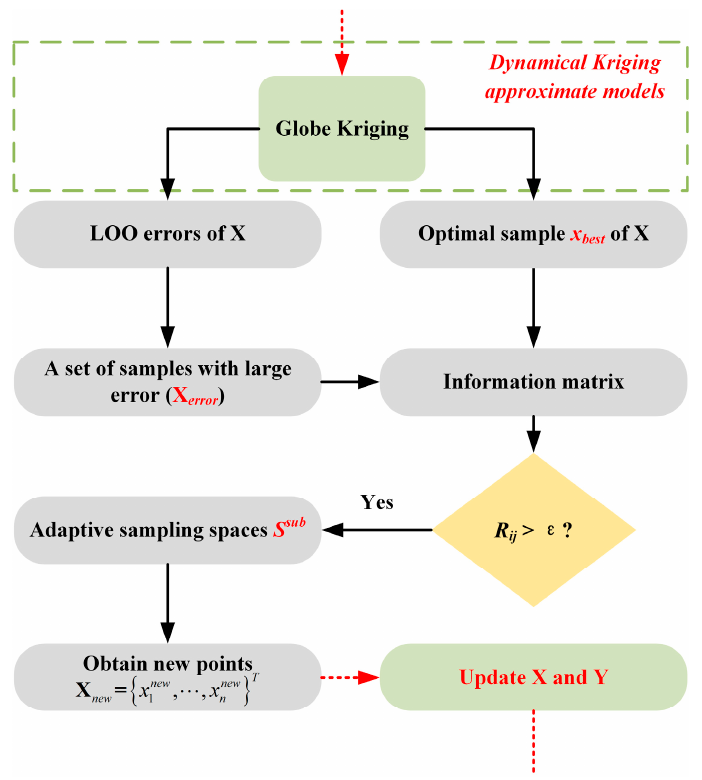
Figure 3. The flowchart of adaptive sampling with the information matrix.